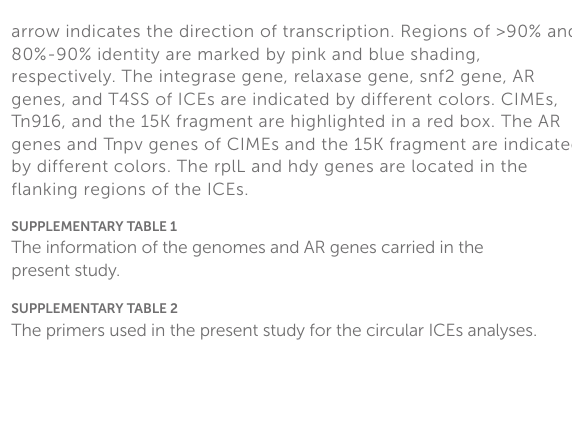
SUPPLEMENTARY FIGURE 1 Schematic comparison of ICESsu32457 carrying 15K fragment and representative ICEs carrying IMEs. The direction of the arrow indicates the direction of transcription. Regions of >90% and 80%-90% identity are marked by pink and blue shading, respectively. The integrase genes, relaxase genes, snf2 genes, ppi genes, AR genes, and T4SS of ICEs are indicated by different colors. IMEs and the 15K fragment are highlighted in a red box. The AR genes and Tnpv genes of IMEs and the 15K fragment are indicated by different colors. The site-specific integrase, AR genes and Tnpv genes of IMEs are indicated by different colors. The rplL and hdy genes are located in the flanking regions of the ICEs. SUPPLEMENTARY FIGURE 2 Schematic comparison of ICESsuBSB6 carrying 15K fragment and representative ICEs carrying CIMEs or Tn916. The direction of the